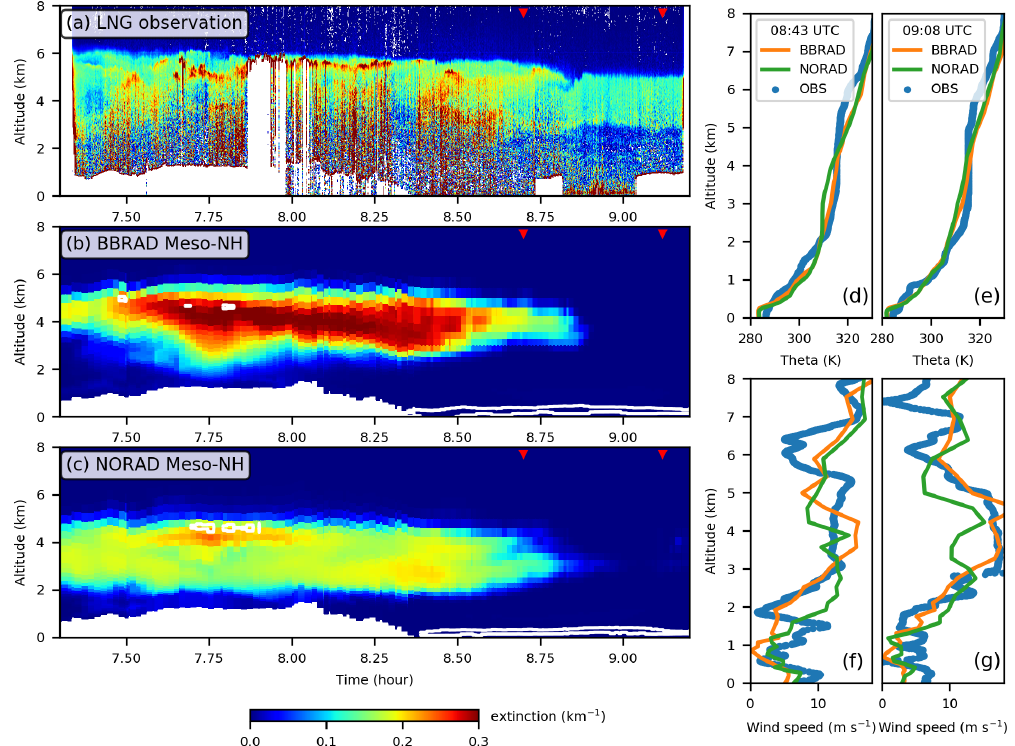
Figure 6. Left column: vertical cross-sections of extinction at 532nm on 6 September 2017 from (a) LNG, (b) BBRAD and (c) NO- RAD along the F20 track shown in Fig. 7. LNG observations were taken between 07:18 and 09:12UTC, and Meso-NH simulations are at 09:00UTC. The white contours show the cloud fraction at 10%. The red triangles indicate the location of the dropsondes. Right column: profiles of (d, e) potential temperature and (f, g) wind speed from dropsondes released at (d, f) 08:43 and (e, g) 09:08UTC (BBRAD and NORAD at 09:00UTC). Results are shown for the BBRAD and NORAD members starting at 00:00UTC on 1 September